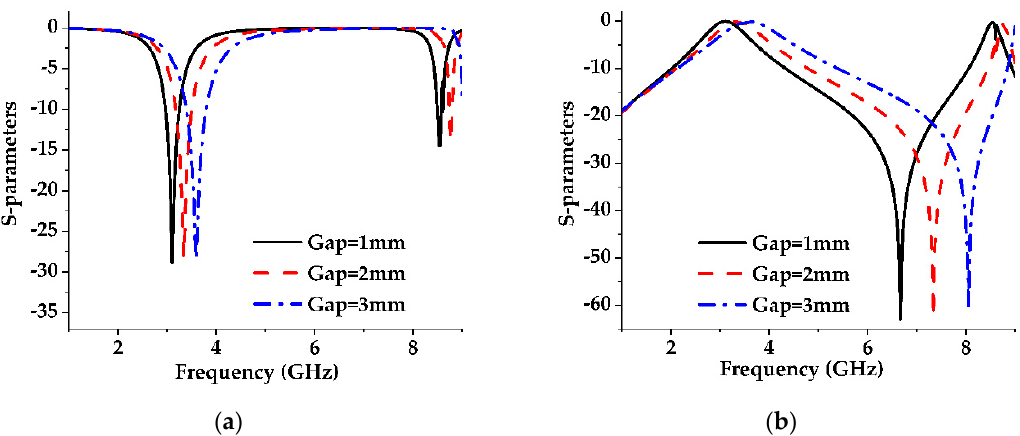
Figure 7. The effect of the gap width on the S-parameters of the parallel dumbbell-shaped DGS unit cell with a constant lattice size of g1 = 11.91 mm and g3 = 10.09 mm. ( a ) S11; ( b ) S21.